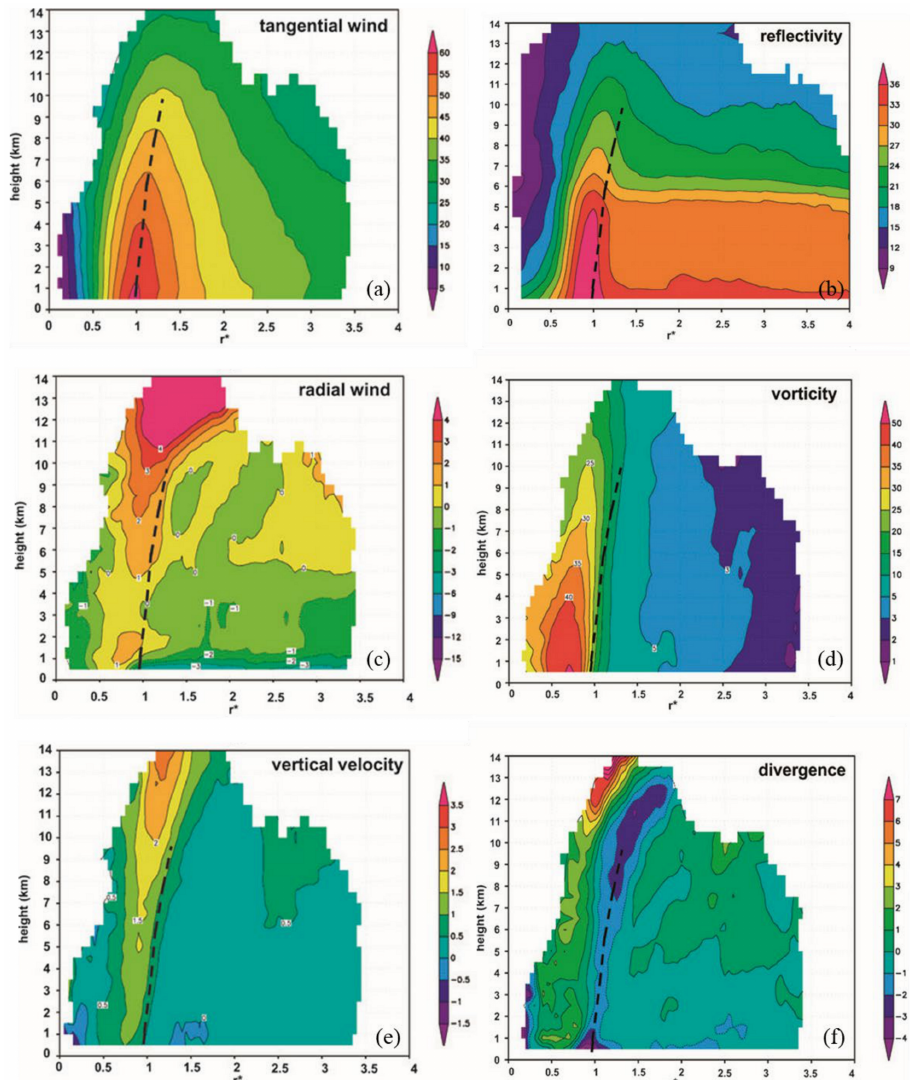
Figure 2. Composite azimuthally-averaged fields of three-dimensional analyses from cases in Rogers et al. (2012). ( a ) tangential wind (m s − 1 ); ( b ) Reflectivity (dBZ); ( c ) Radial wind (m s − 1 ). ( d ) Relative vorticity ( × 10 − 4 s − 1 ); ( e ) Vertical velocity (m s − 1 ); ( f ) Horizontal divergence ( × 10 − 4 s − 1 ). Data from a minimum of 20 analyses are required for plotting. All composites plotted as a function of normalized radius r* and height above ground level. The dashed line denotes the axis of peak ax- isymmetric tangential wind from 0.5- to 10-km altitude calculated from the composite in ( a ). Adapted from